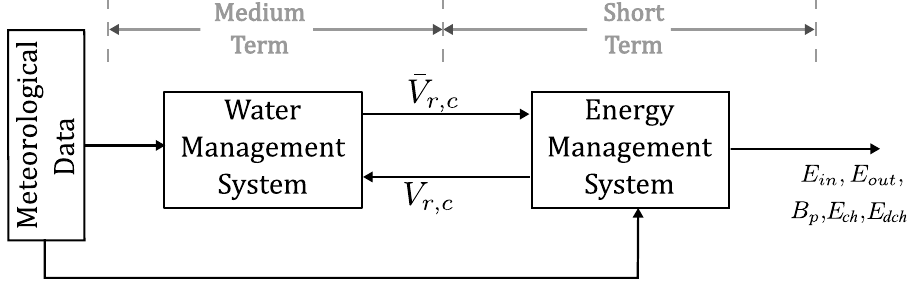
Figure 2. Integrated EWMS